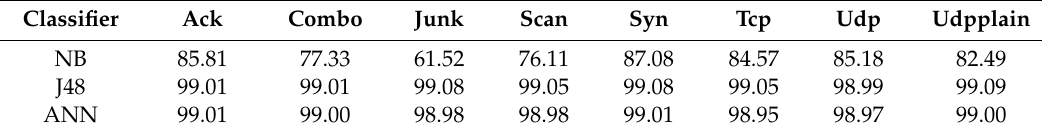
Table 1. Detection accuracy without feature selector.